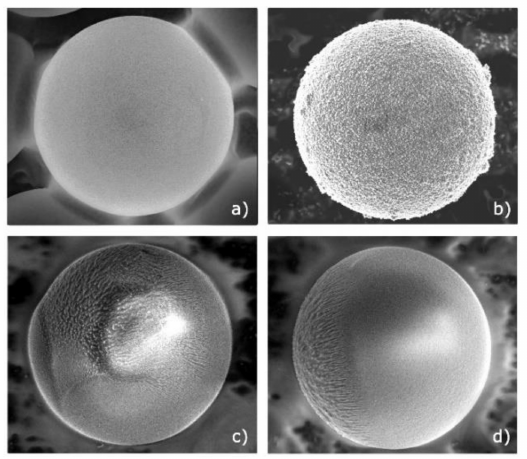
Figure 1. SEM photographs of a spherical monodisperse melamine-formaldehyde (MF) particle with a diameter of 10 µ m: ( a ) without coating; ( b ) with a surface coated by copper; ( c , d ) Janus particles with iron partly-coated